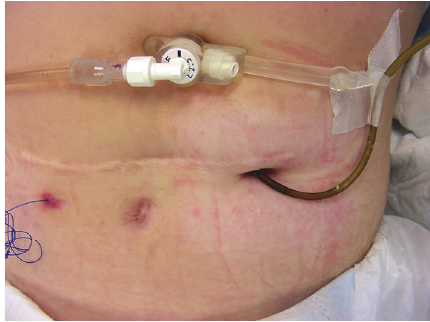
Figure 7: Photograph of a discolored jejunal feeding tube before tube exchange. Note the coiled guide thread to the left of the scar and gastrostomy button in the epigastrium.